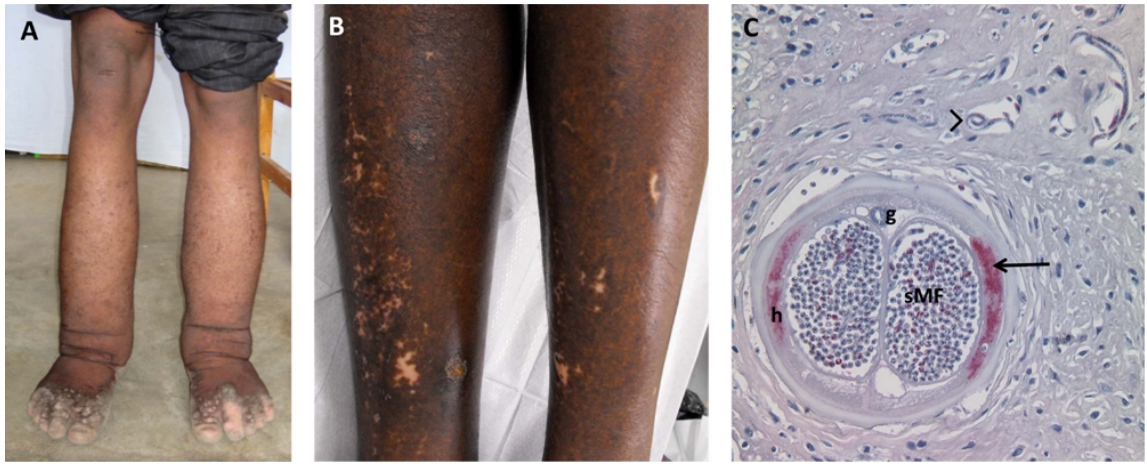
Figure 1: Filarial pathological